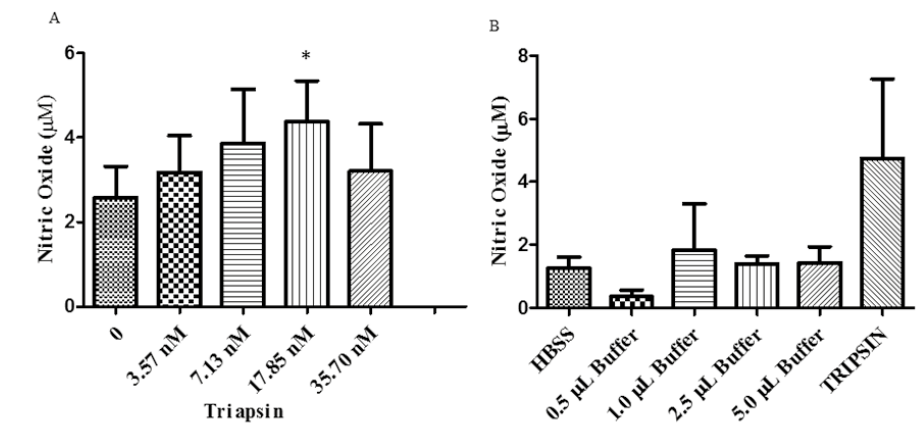
Figure 4. Analysis of triapsin-induced endothelial NO release by cultured HUVECs (human umbilical vein endothelial cells). (A) Dose-dependent NO release by cultured HUVECs induced by triapsin quantified by the fluorescent dye for nitrite/nitrate (DAN). Data show the mean ± S.E.M. from five experiments with 5 x 10 3 cells. One-way ANOVA with Dunnett’s multiple comparisons test, followed by a ratio-paired t-test were used to calculate differences to control; *p < 0.05. (B) Stimulation of NO release by HUVECs measured in the presence of different amount of triapsin-buffer in the same volumes used for the triapsin dose- dependent curve (n = 3). One-way ANOVA with Dunnett’s multiple comparisons test was used to calculate differences. Trypsin (50 nM) was used as a positive control.